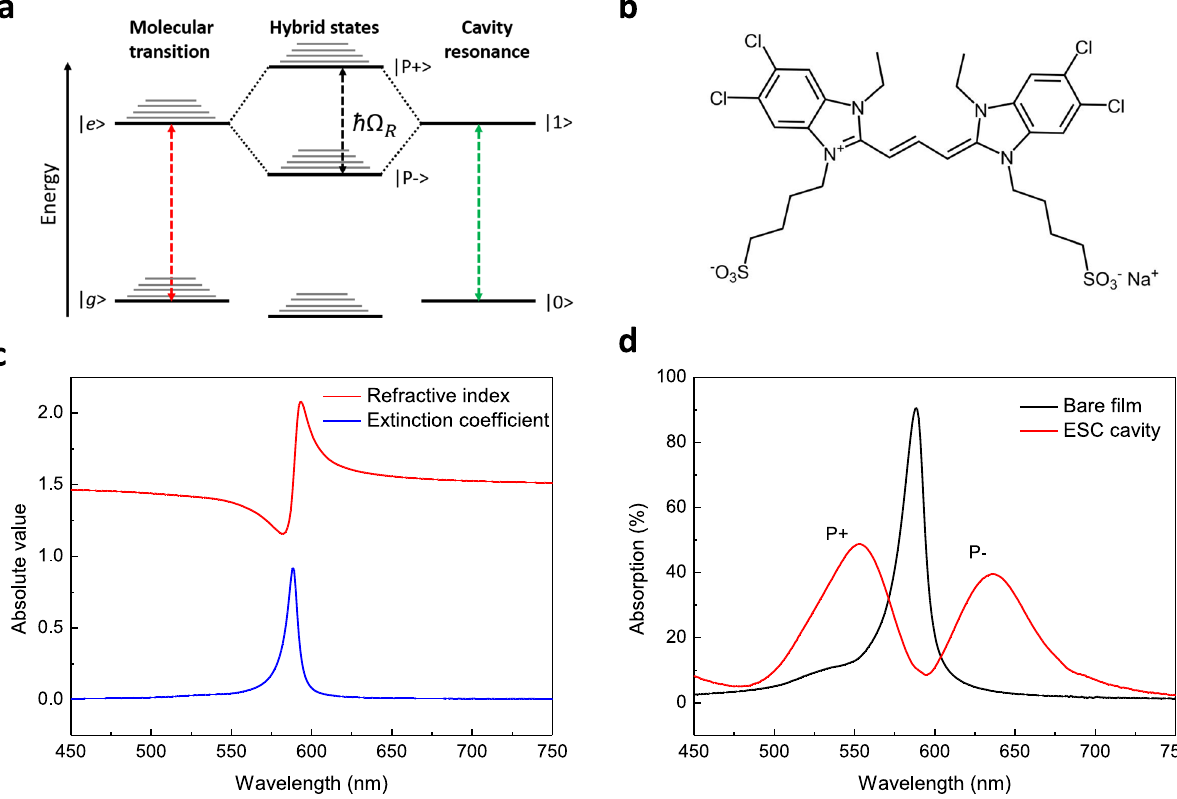
Fig. 1 Light-matter strong coupling with organic semiconductors and linear responses of the samples. a Schematic energy diagram of the strong coupling between a molecular exciton transition and a cavity resonance. b Chemical structure of the J-aggregating cyanine monomer used in this work that eventually aggregate in the J-form. (See Methods). c Linear refractive index (red curve) and extinction coef fi cient (blue curve) of the bare J-aggregate molecular fi lm calculated by transfer-matrix method. d Linear absorption spectra of the bare J-aggregate molecular fi lm (no cavity - black curve) and of the molecular fi lm under strong coupling (inside the FP cavity - red curve) at normal